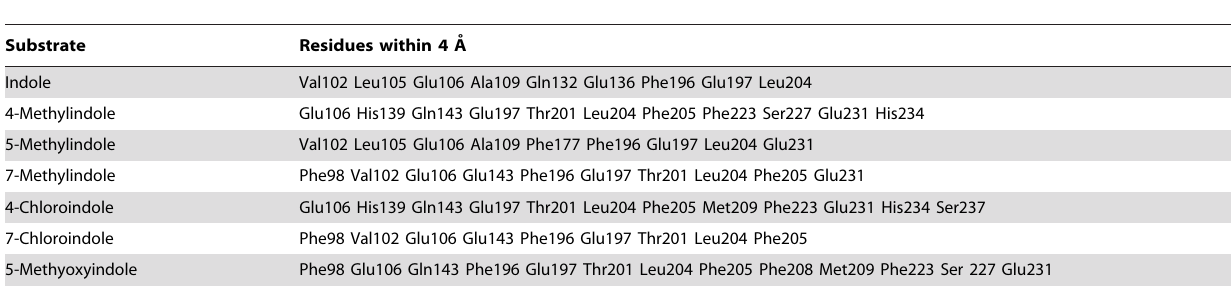
Figure 4. Interactions between PHN W1 component and indole derivatives. Orientations of docked indoles in the active site of PHN W1 component: A. Indole; B. 4-Methylindole; C. 5-Methylindole; D. 7-Methylindole; E. 4-Chloroindole; F. 7-Chloroindole; G. 5-Methyoxyindole; H. 3- Methylindole. Atom designation: carbon atom, blue; hydrogen atom, white; chlorine atom, green; oxygen atom, red. Orange spheres represent for diiron, of which located above is designated as Fe1; green represent for tunnel entrance residues Asn-202 and Phe-205; other important residues are shown in grey. doi:10.1371/journal.pone.0044313.g004 Table 3. Residues involved in binding different